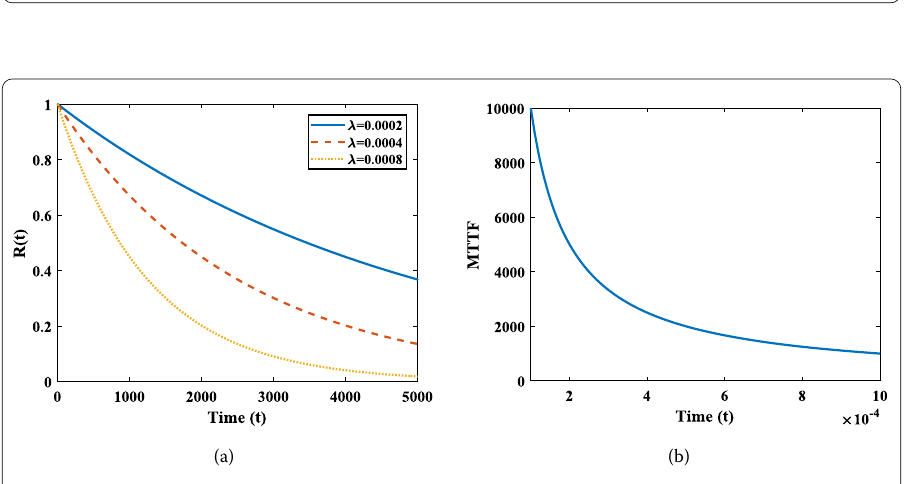
Figure 6 System reliability and MTTF for exponentially distributed repair time. ( a ) Reliability for different λ ; ( b ) Effect of λ on